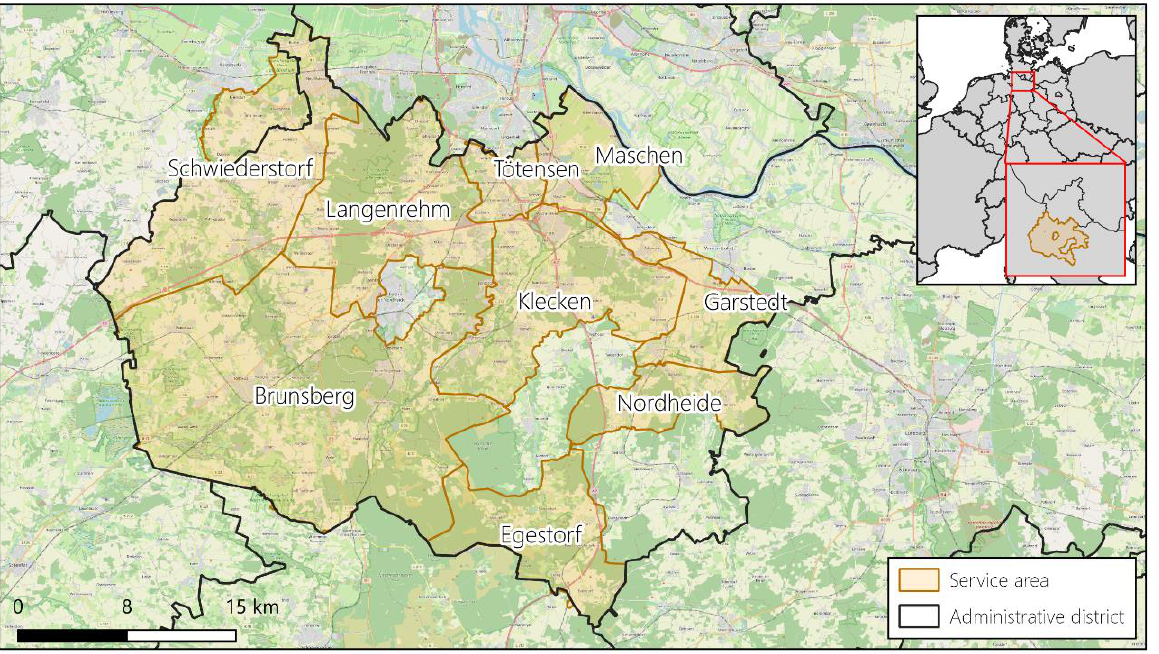
Figure 1. Location of the service area (orange shaded area) and the nine service zones of the Wasserversorgungsverband (WBV) Harburg. The different names of the service zones are given. The background map is taken from OpenStreetMap.